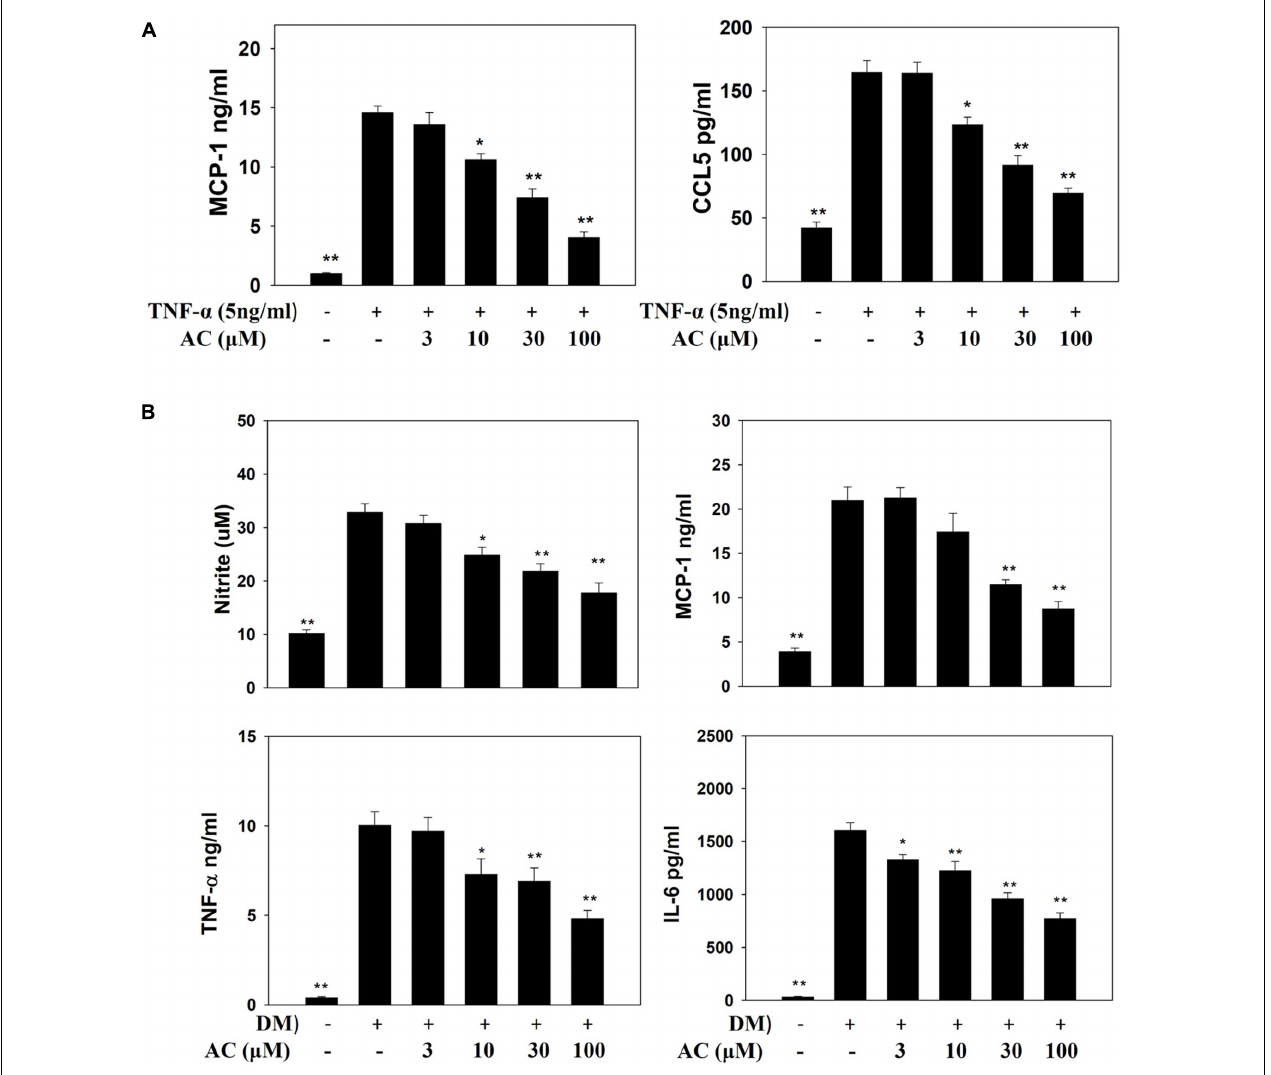
FIGURE 5 | The effect of acacetin (AC) (3–100 µ M) on nitrite, chemokines, and cytokine levels as measured by ELISA. (A) The protein expression of MCP-1 and CCL5 was measured in TNF- α -induced 3T3-L1 cells treated with acacetin. Data are presented as means ± SD. ∗ P < 0.05, ∗∗ P < 0.01 compared to differentiated 3T3-L1 cells (control group). (B) Macrophages were cultured in differentiated media (DM) and treated with acacetin for 24 h, then the levels of nitrite, MCP-1, IL-6, and TNF- α were determined. Data are presented as means ± SD ( n = 6); ∗ P < 0.05, ∗∗ P < 0.01 compared with the ‘macrophages cultured in DM’